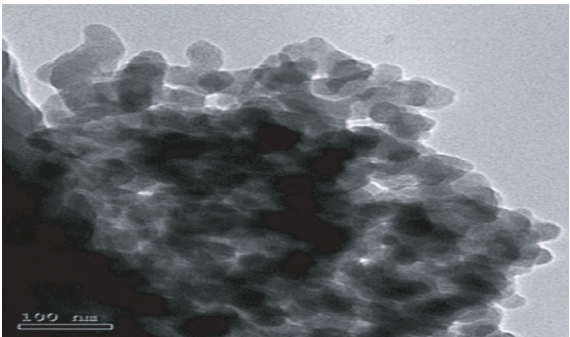
Figure 1: TEM images of NNG showing the shape and size of NNG, which appear as spherical particles with an average size of